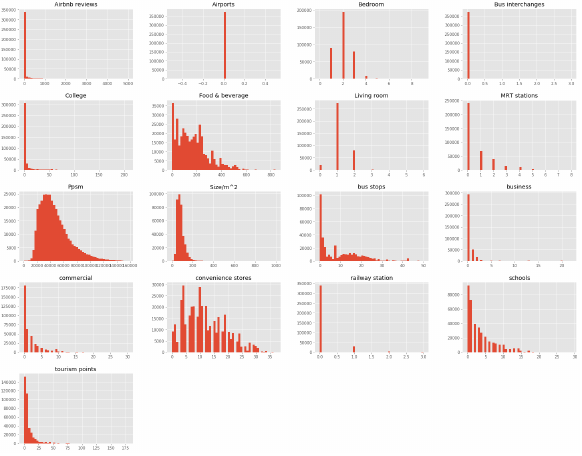
Figure 4. Numeric variables histogram plots.